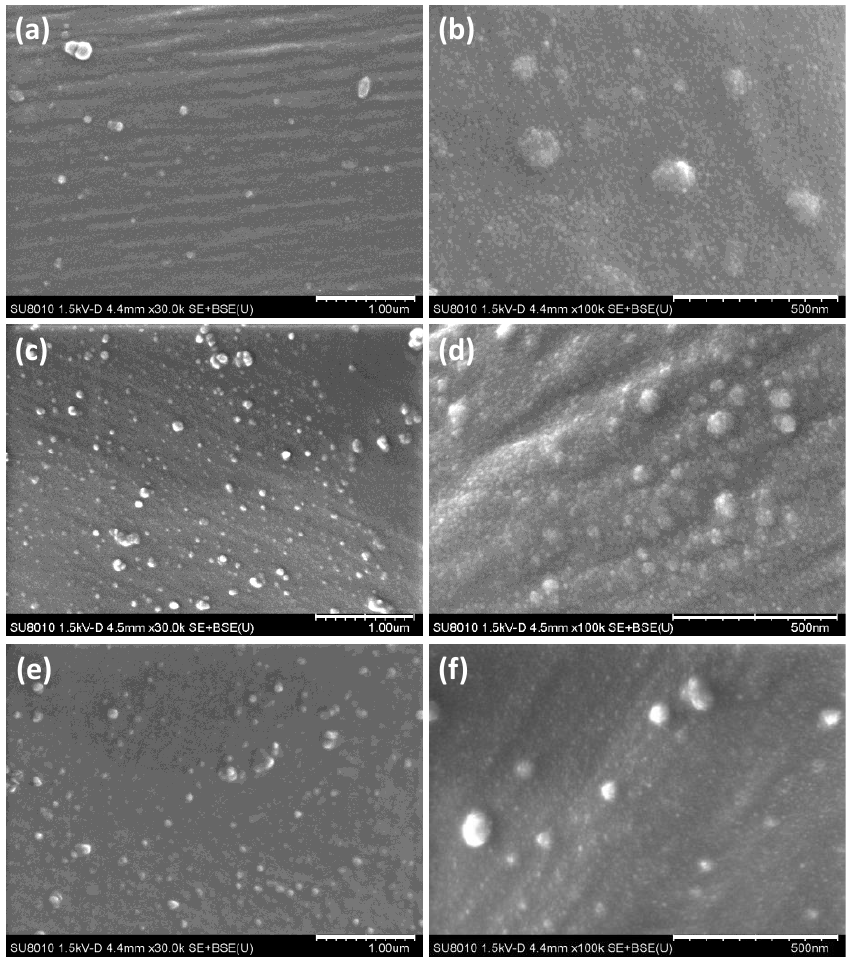
Figure 2. Scanning electron microscopy (SEM) images of the silk fabrics treated with different concentrations of Pt ions: ( a , b ) 0.2 mM (PSF2); ( c , d ) 0.3 mM (PSF3); ( e , f ) 0.4 mM (PSF4).